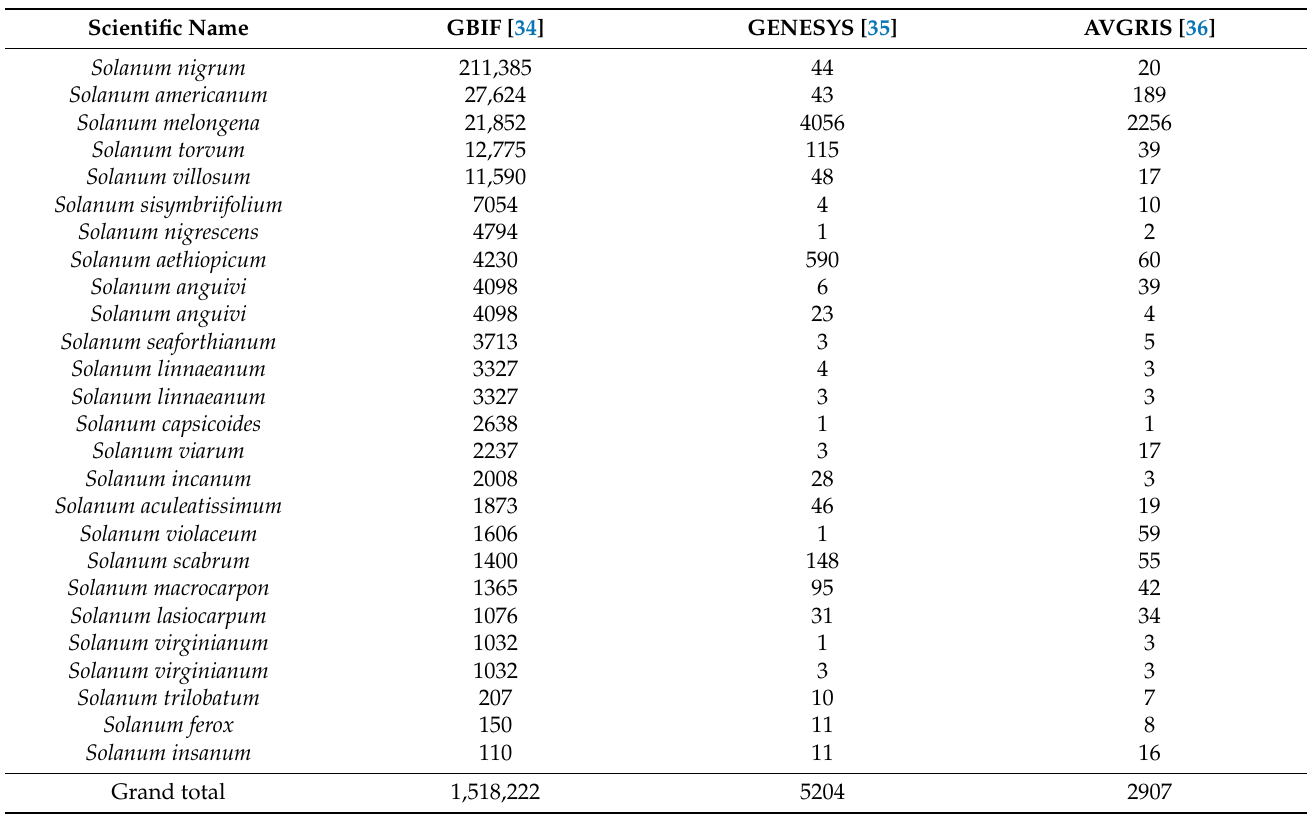
Table 3. Occurrences and conserved accessions in genebank of cultivated eggplant and wild